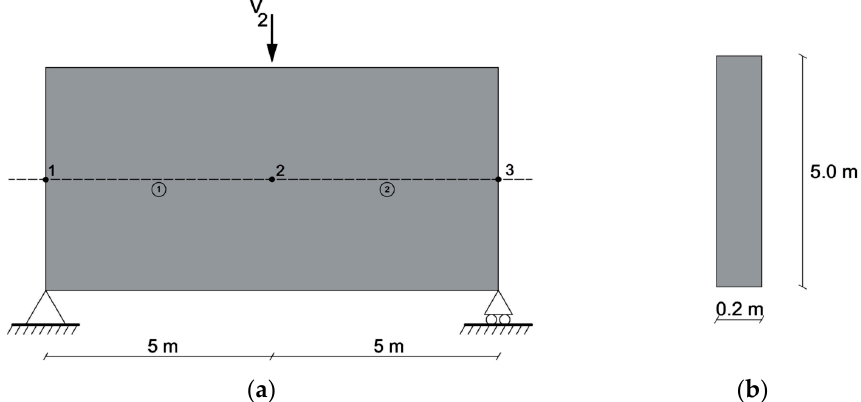
Figure 2. Example 1: simply supported structure: ( a ) finite element model and ( b ) cross-section.